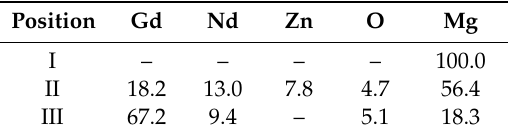
Table 3. Corresponding of the energy-dispersive X-ray spectrometry (EDS) results of points in the as-cast Mg-5Gd alloy in Figure 2a (atom,